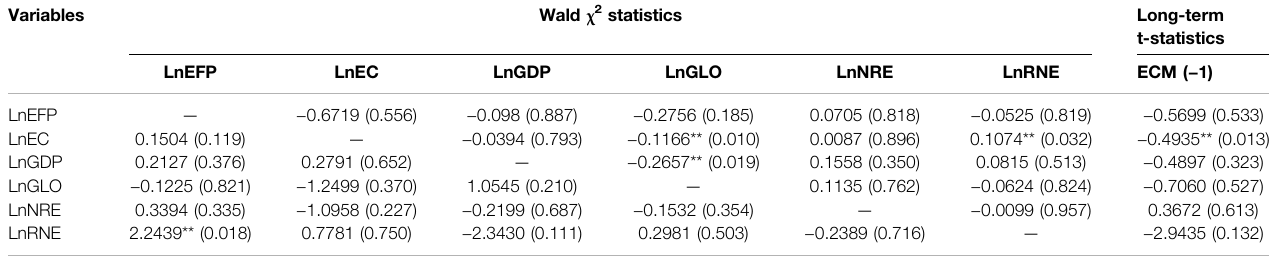
TABLE 9 | Results of VECM Granger causality.